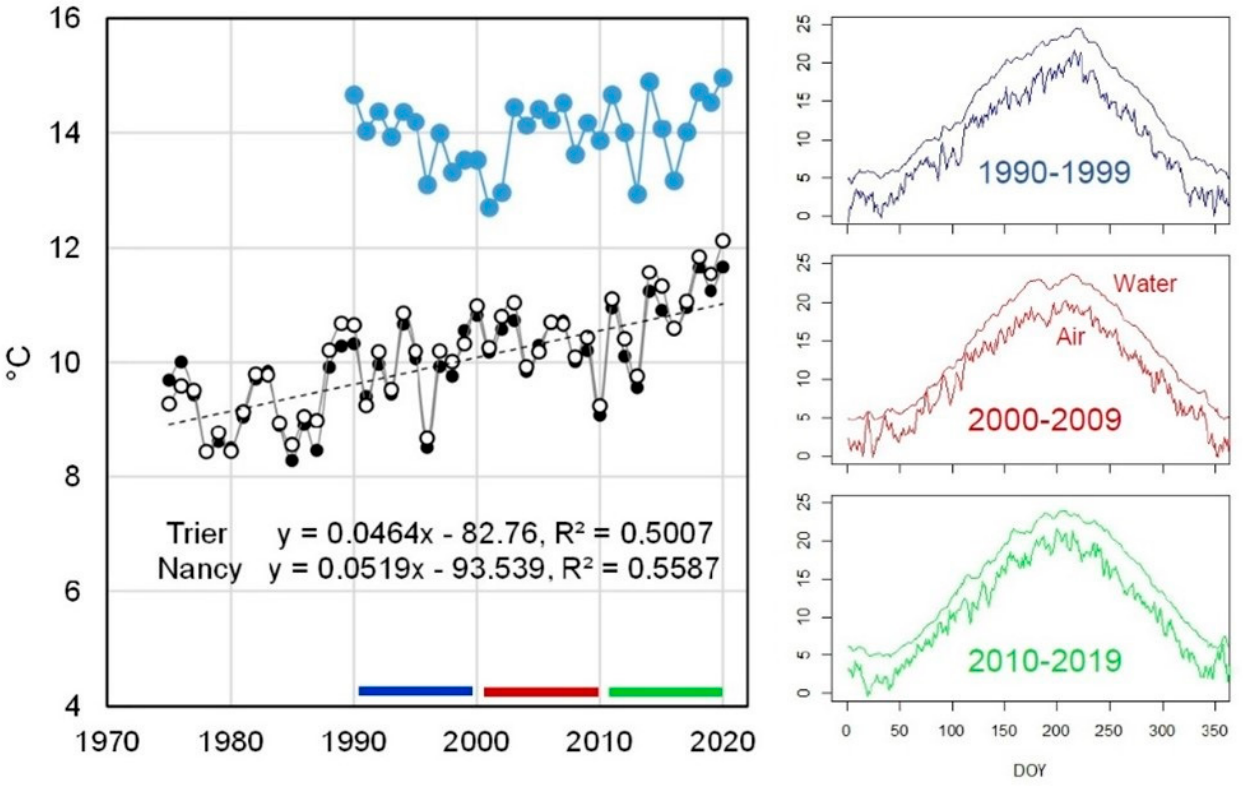
Figure 2. Mean annual air temperatures in Nancy–Ochey ( ○ , 1975–2020), Trier − Petrisberg ( ● , 1975–2020) and water temperatures in Palzem (blue dots, 1990–2020). Right-hand side panels refer to air and water temperatures recorded in Trier and Palzem, respectively. Values are given as daily means for three decades. “DOY” refers to day of the year: DOY 1 is 1 January.